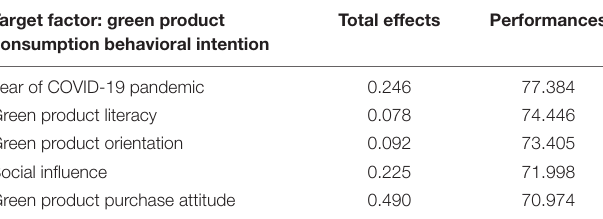
TABLE 4 | Performance and total